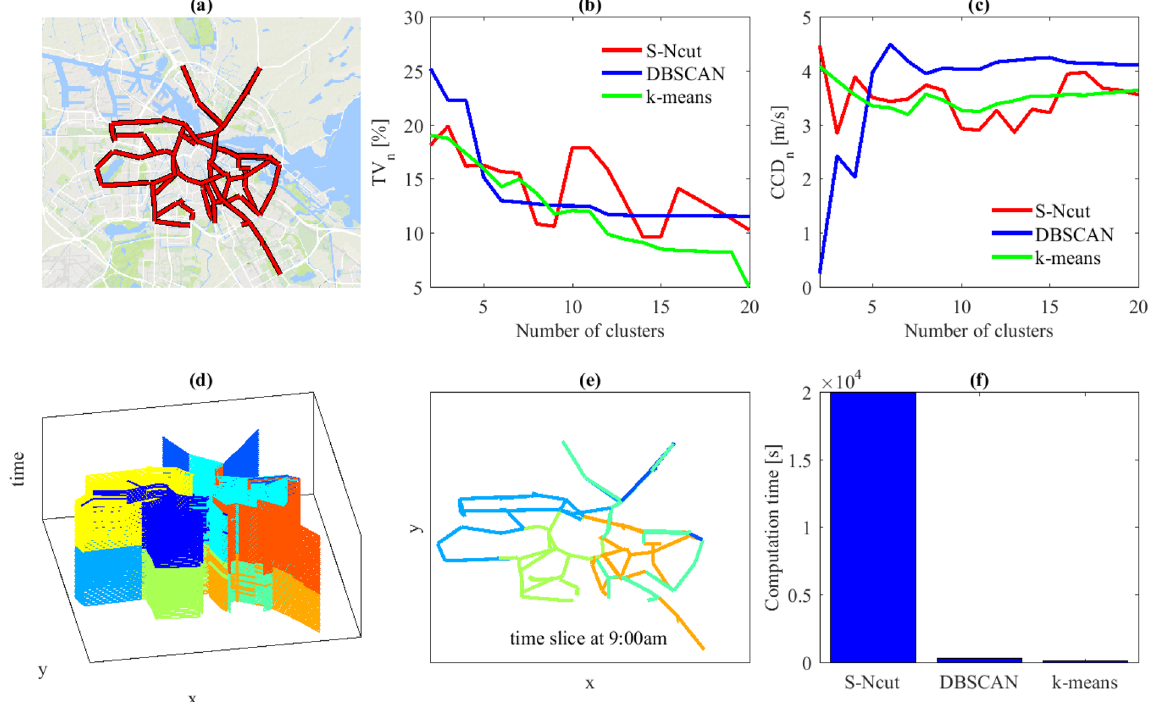
Figure 1. Link speed 3D clustering for one particular day. ( a ) Sketch of Investigated network - Amsterdam city (NL) - MapData @2017 Google ( b , c ) Evolution of the total variance ( TV n ) and the connected cluster dissimilarity ( CCD n ) with respect to the number of cluster for different clustering methods ( d ) Resulting 3D speed maps for 9 clusters ( e ) Slide of the 3D speed map for time period t = 9am ( f ) Computational times for different clustering methods and a targeted number of clusters equal to 9. Graphs ( b,c,f ) show that the clustering algorithms that do not consider the graph topology, i.e. the k-mean and the DBSCAN, blast the S-Ncut in terms of computational times with analogous TV n and CCD n results. DBSCAN appears very stable when the number of cluster exceeds 6. Selecting 9 clusters looks optimal for this dataset and network